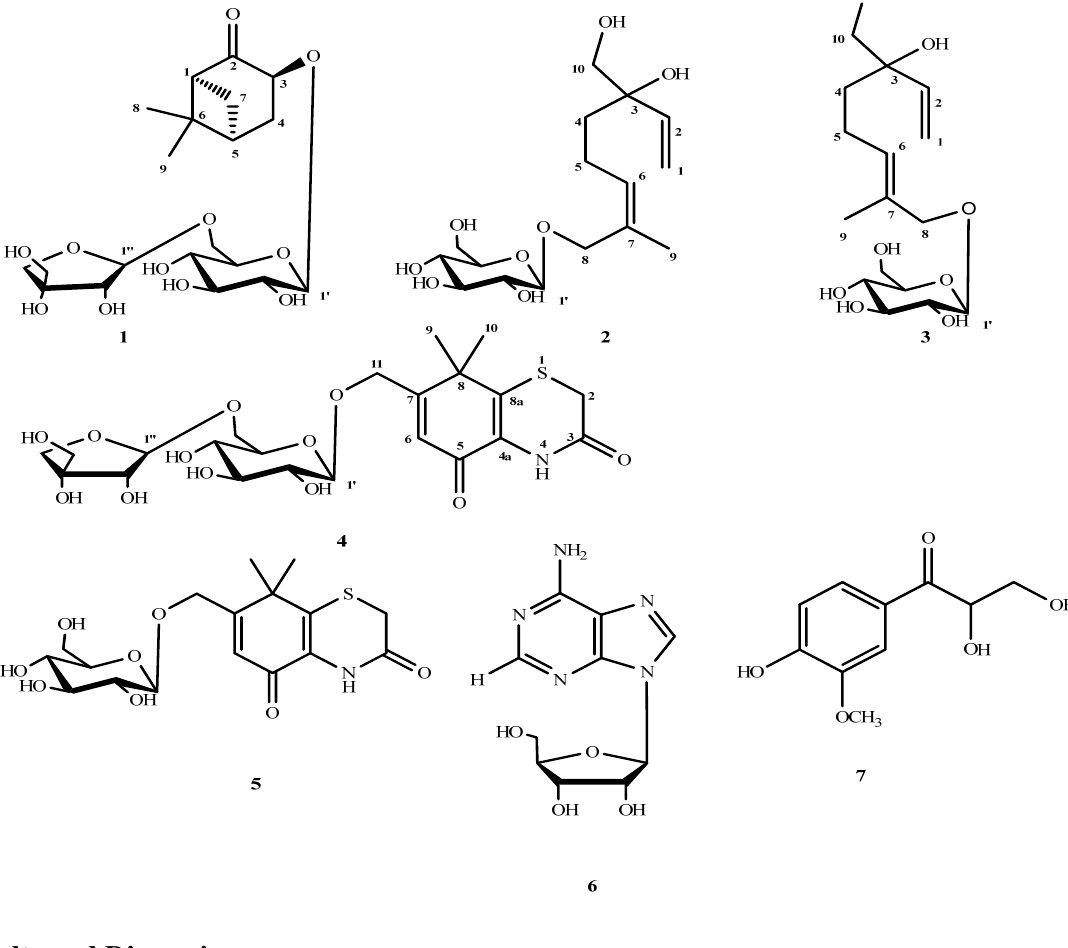
Figure 1. Structures of compounds 1 – 7 isolated from Fructus Xanthii